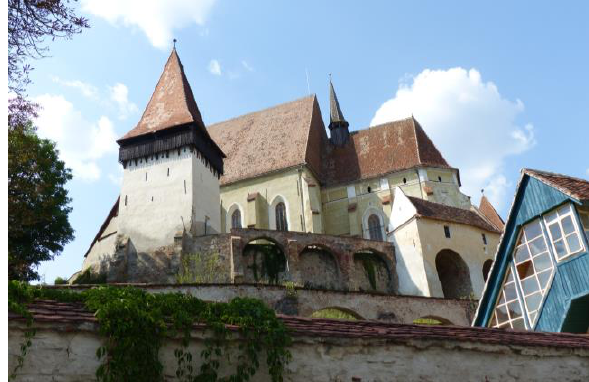
Figure 4. Biertan Fortified